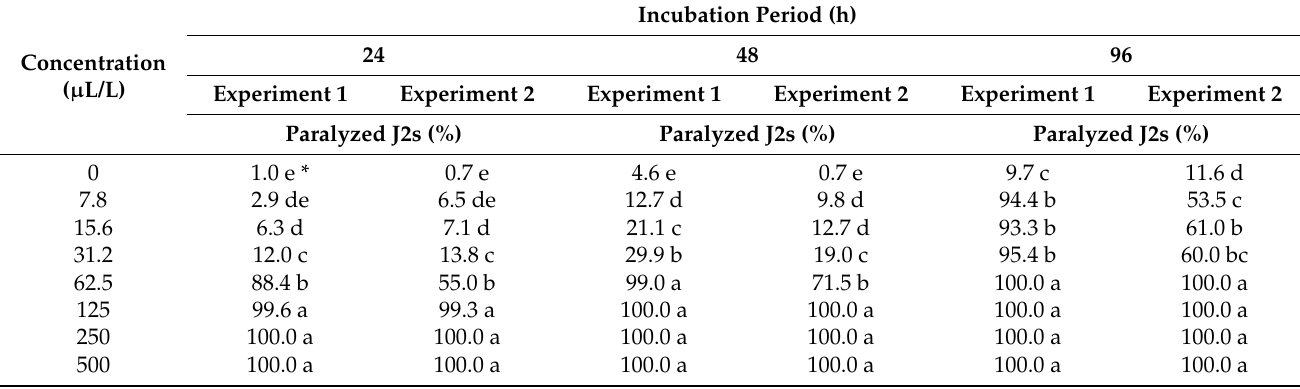
Table 2. Motility percentages of Meloidogyne incgonita second-stage juveniles (J2s) after immersion in Cuminum cyminum seed essential oil at 0, 7.8, 15.6, 31.2, 62.5, 125, 250, and 500 µ L/L concentrations for 24, 48, and 96 h exposure times.